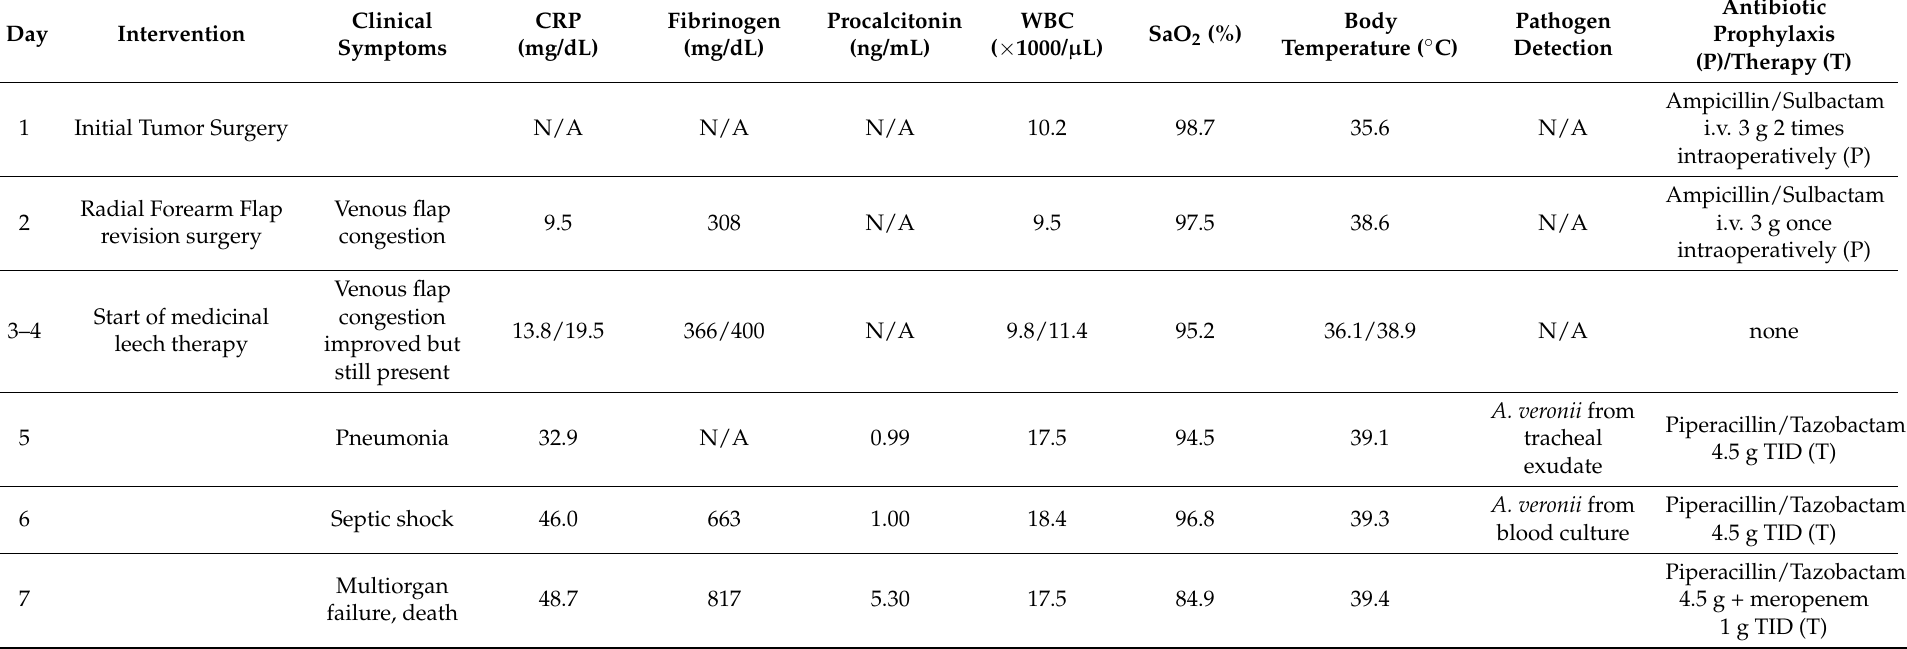
Table 2. Clinical Status and medical intervention Protocol; (P = prophylaxis, T = therapy, TID = 3 times